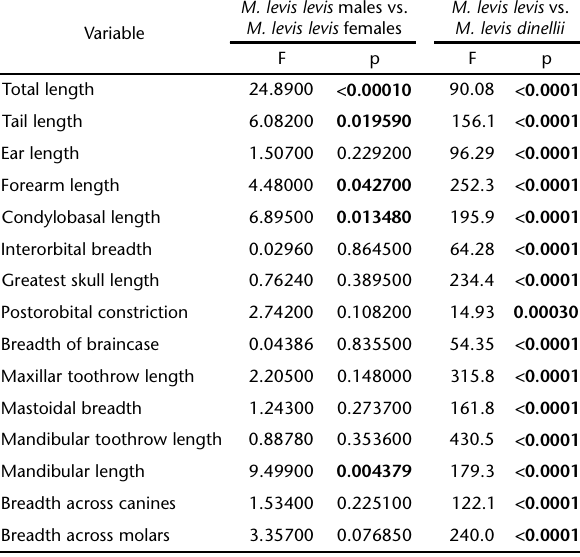
Table I. One-way ANOVAs of 15 log-transformed morphometric traits of the Myotis levis levis and M. levis dinellii . Numbers in bold indicate significant differences.